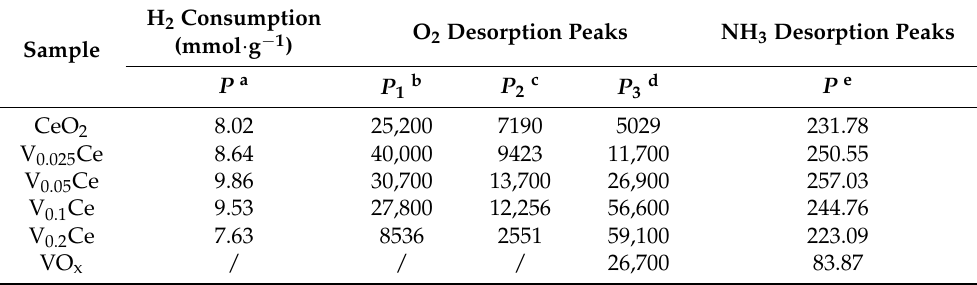
Figure 5. ( a ) Hydrogen temperature programmed reduction (H 2 –TPR) and ( b ) the initial H 2 con- sumption rate of prepared catalysts. Table 3. H 2 –TPR, O 2 –TPD, and NH 3 –TPD results of prepared